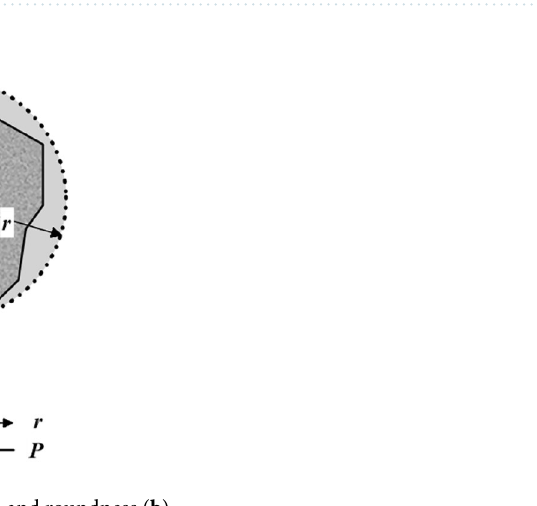
Figure 2. Schematic diagram of aspect ratio ( a ) and roundness ( b